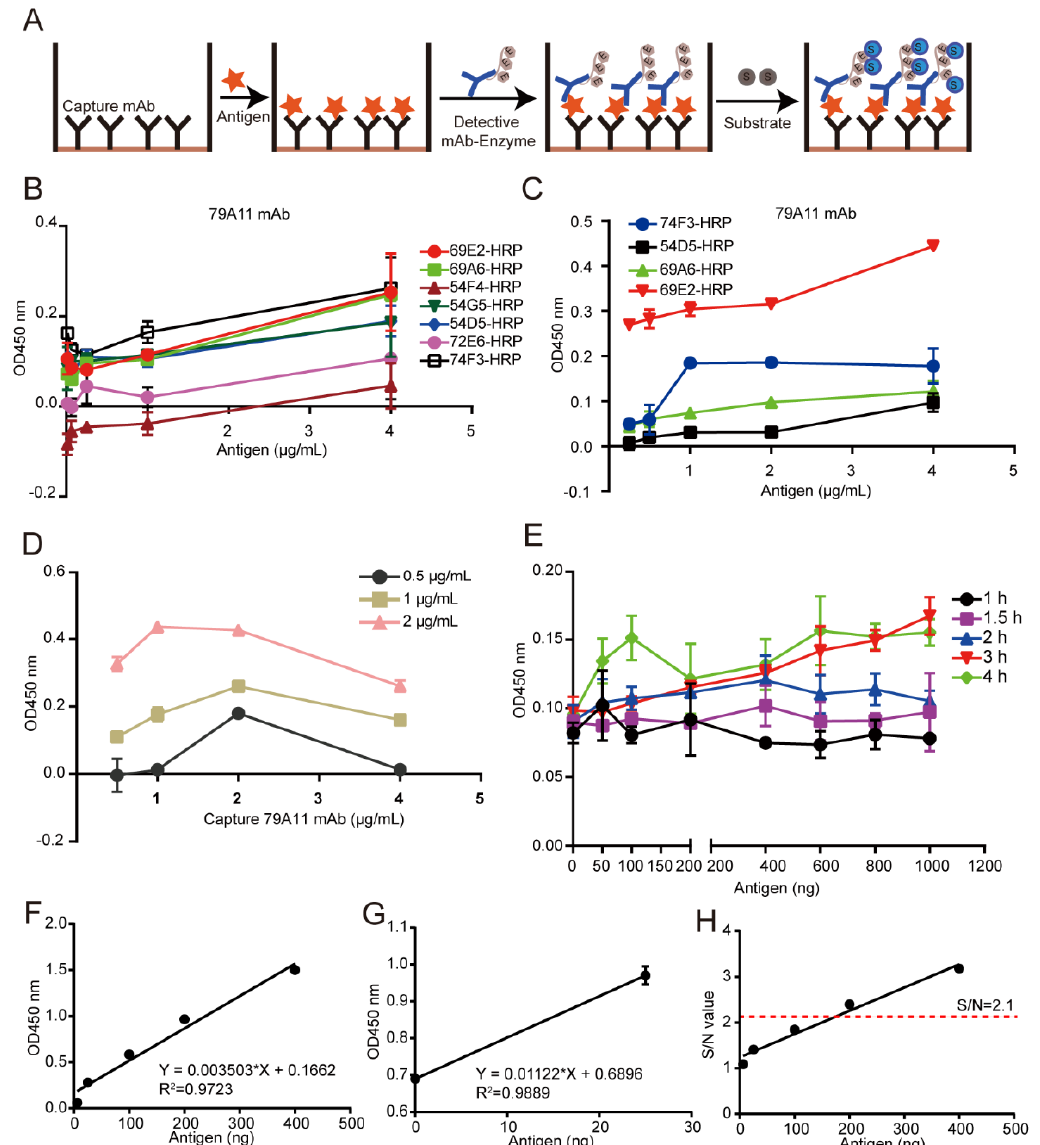
Figure 5. Establishment of a double-antibody sandwich ELISA based on an HRP-labeled mAb and a TMB detection system for quantitative detection of the HPV16 E7-HIS fusion oncoprotein. The red pentagram represents an antigen; the black “Y” represents a capture antibody; the blue “Y” represents a detecting antibody; E represents an HRP enzyme and S represents a substrate (TMB). ( A ) Schematic diagram of the double-antibody sandwich ELISA. The principle of a conventional double-antibody sandwich ELISA: an mAb without the labeled enzyme HRP was used as the capture antibody, and an HRP-labeled mAb was added after the antigen reaction, and the color substrate TMB was used to develop the color. The OD 450nm value was used to calculate the amount of antigen in the picture. ( B ) The positive result of the first mAb pairing. ( C ) The re-pairing results of four pairs of mAbs with positive signals. ( D ) The optimization of the capture antibody concentration. ( E ) The optimization of the reaction time between the antigen HPV16 E7 protein and the capture antibody. ( F ) The linear relationship diagram between the antigen HPV16 E7 protein content and the OD 450nm detected by double-antibody sandwich ELISA. ( G ) The regression equation for calculating the detection limit of the antigen. ( H ) The linear relationship diagram between the antigen HPV16 E7 protein content and the S / N value of antigen detected by double-antibody sandwich ELISA. HRP, horseradish peroxidase; TMC,